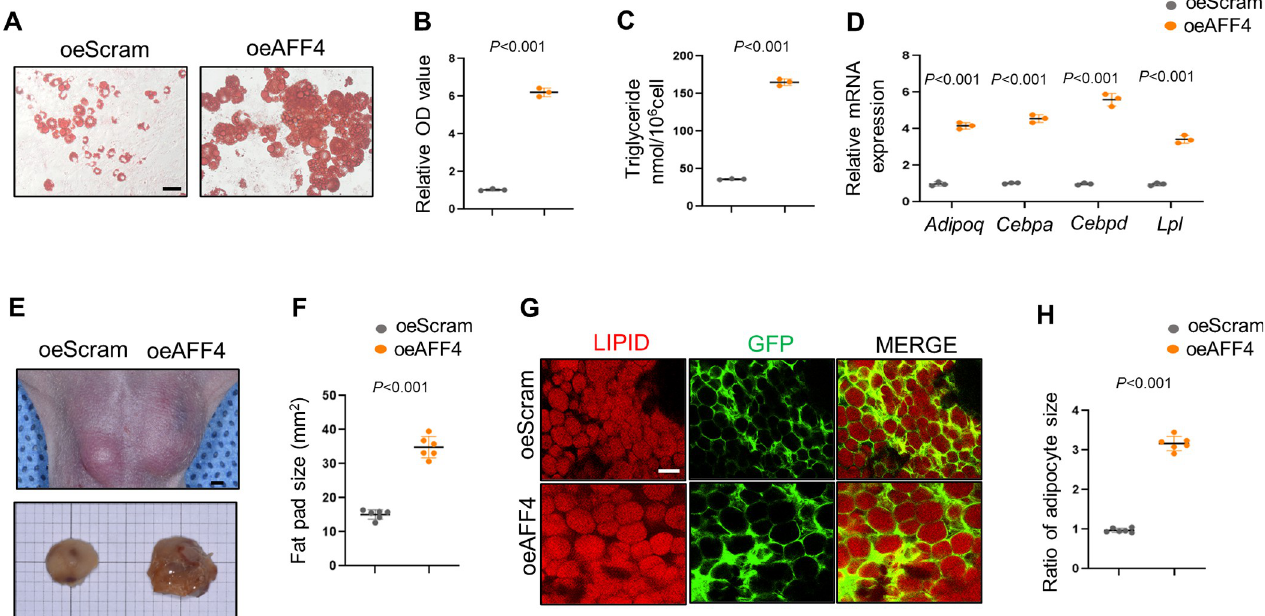
Fig 2. Overexpression of AFF4 enhances adipogenesis. (A-D) Adipogenesis in AFF4-overexpressing cells. (A) Representative images of oil red o staining of 3T3-L1 cells. (B) Quantification of oil red o staining, absorbance at 518 nm. n = 3. (C) Triglyceride quantification. n = 3. (D) RT-qPCR of adipogenic markers. n = 3. (E-H) Ectopic fat formation in nude mice. (E) Xenograft of oeScram and oeAFF4 3T3-L1 cells in nude mice and samples were collected after 6 weeks. Scale bar, 1mm. (F) Fat pad size quantification. n = 6. (G) Representative immunofluorescent images of lipids. Scale bar, 50 μ m. (H) Adipocyte size quantification. n = 6. All quantified data are presented by as mean ± SD. The P values were calculated by two-tailed Student’s t-test.